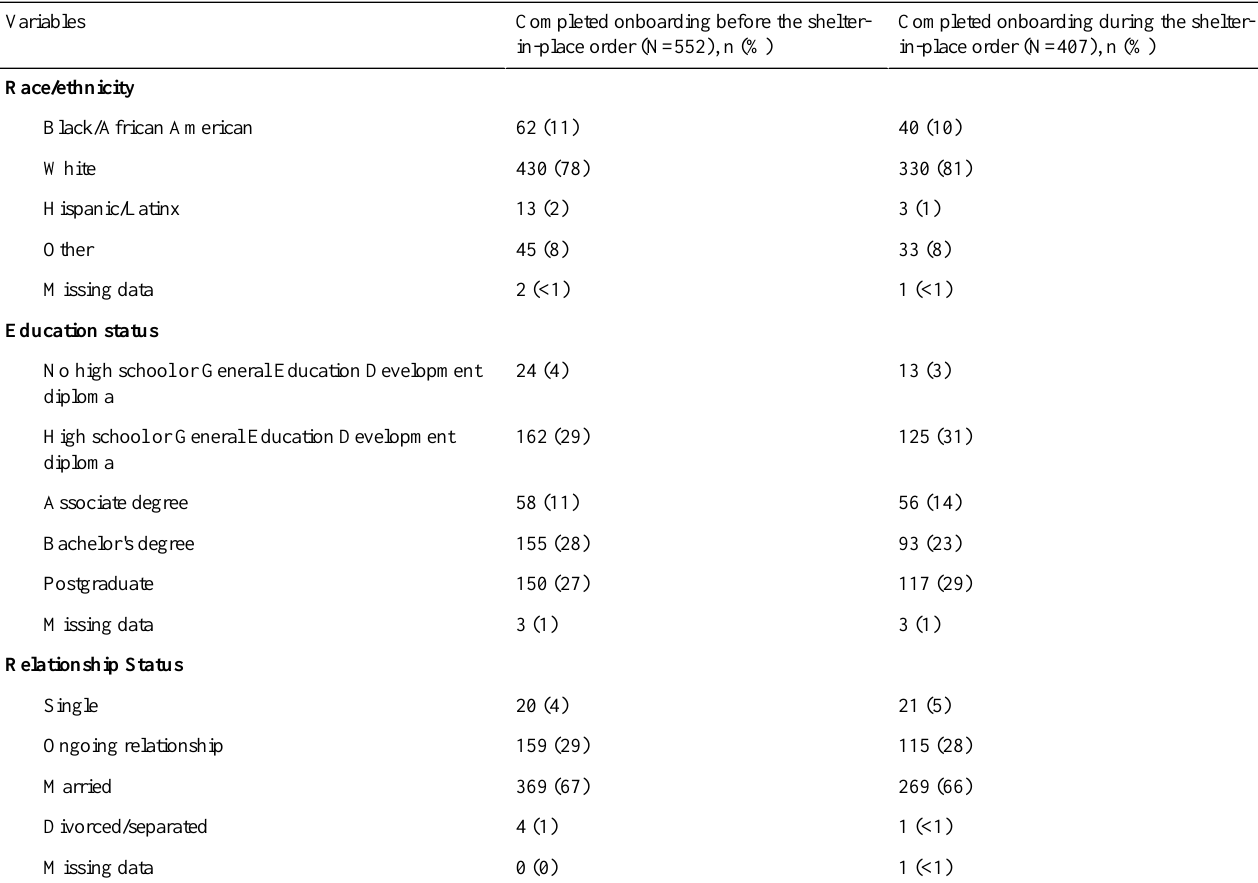
Table 1. MyHealthyPregnancy app user demographics. The demographic distribution of the sample reflects the demographic distribution of the health care system’s pregnant